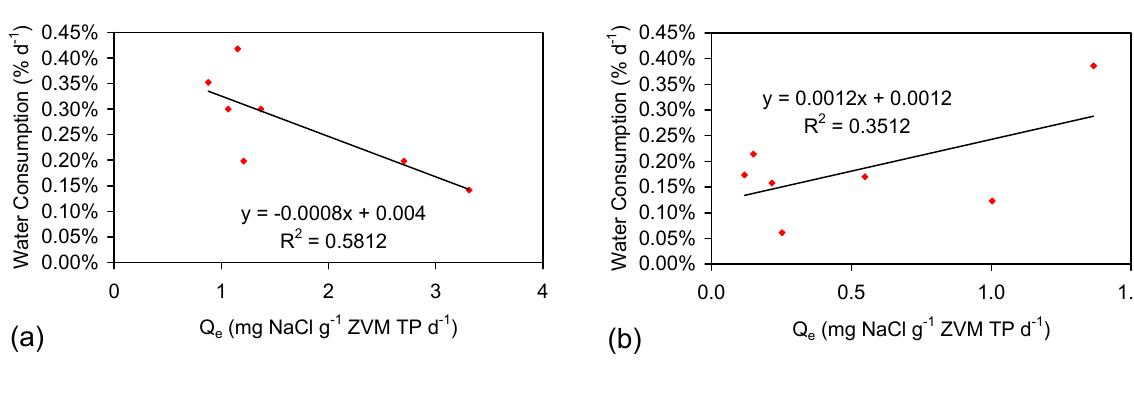
Figure 6. Water consumption vs. Q e . ( a ) Type A + B Pre-treatment; ( b ) Type C + D Pre-treatment. Data: Table